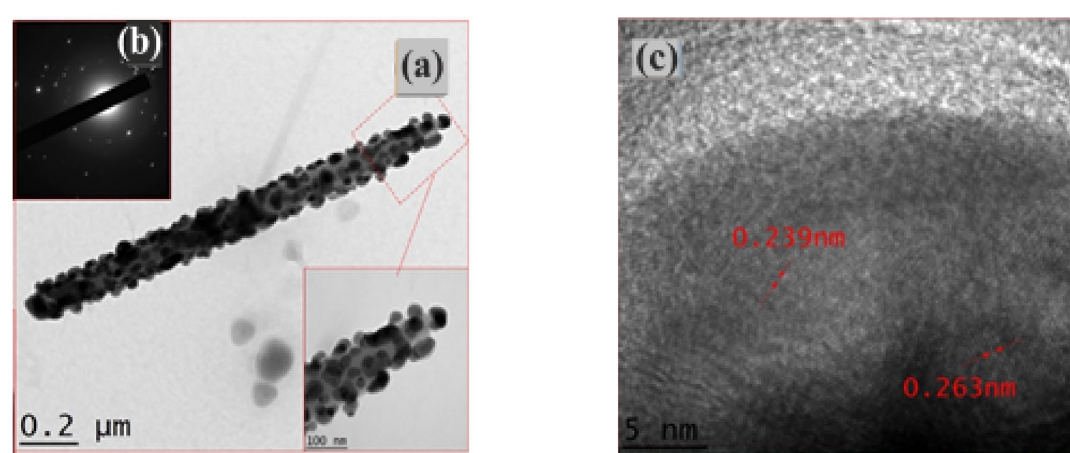
Figure 4. Ag 2 S nanoparticle/ZnO NRAs ( a ) TEM image, ( b ) SAED and ( c ) HRTEM